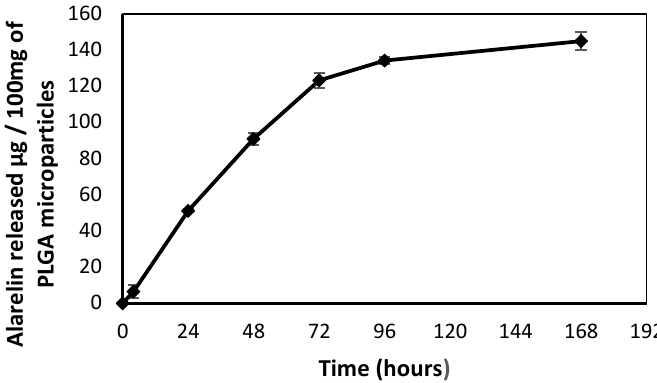
Figure 1. Release kinetics of Alarelin from PLGA microparticles.